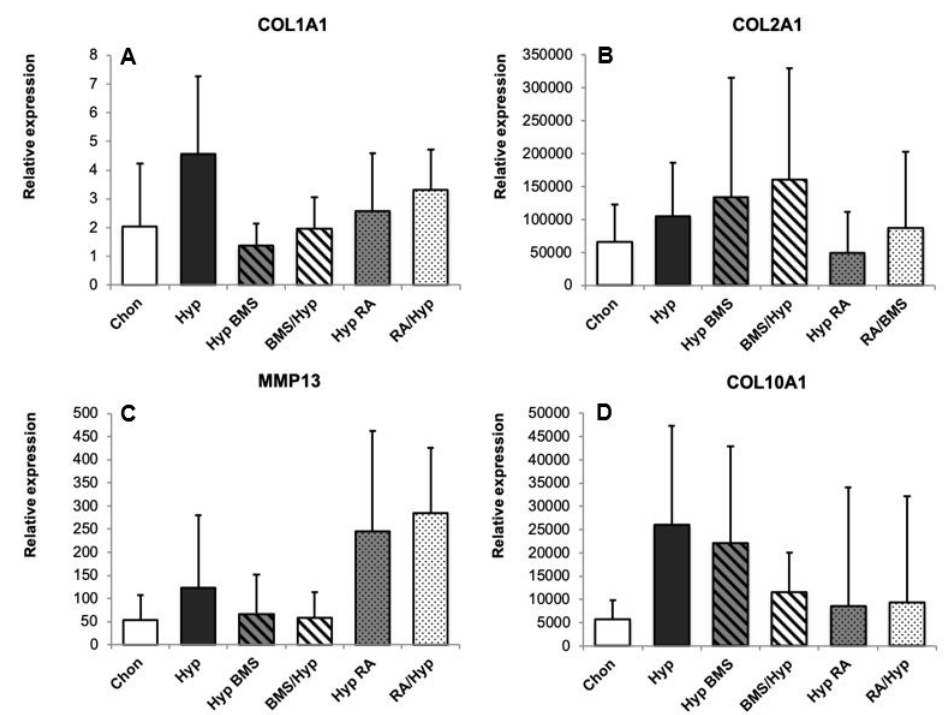
Figure 6. E ff ect of BMS and RA on gene expression. Quantitative PCR of the osteogenic marker collagen type I ( A ); the chondrogenic marker collagen type II ( B ); and the hypertrophic markers, MMP13 ( C ); and collagen type X ( D ), in MSC aggregates on Day 28. Relative gene expression normalized to Day 0 is given for n = 3 MSC donor populations in groups obtaining RA resp. n = 6 populations in other groups. Gene abbreviations are according to the NCBI database. Whiskers represent standard deviations. Chon, chondrogenic control group; Hyp, hypertrophic control group; Hyp BMS, hypertrophic group with late BMS treatment; BMS / Hyp, hypertrophic group with early BMS treatment; Hyp RA, hypertrophic group with late retinoic acid treatment; RA / Hyp, hypertrophic group with early retinoic acid